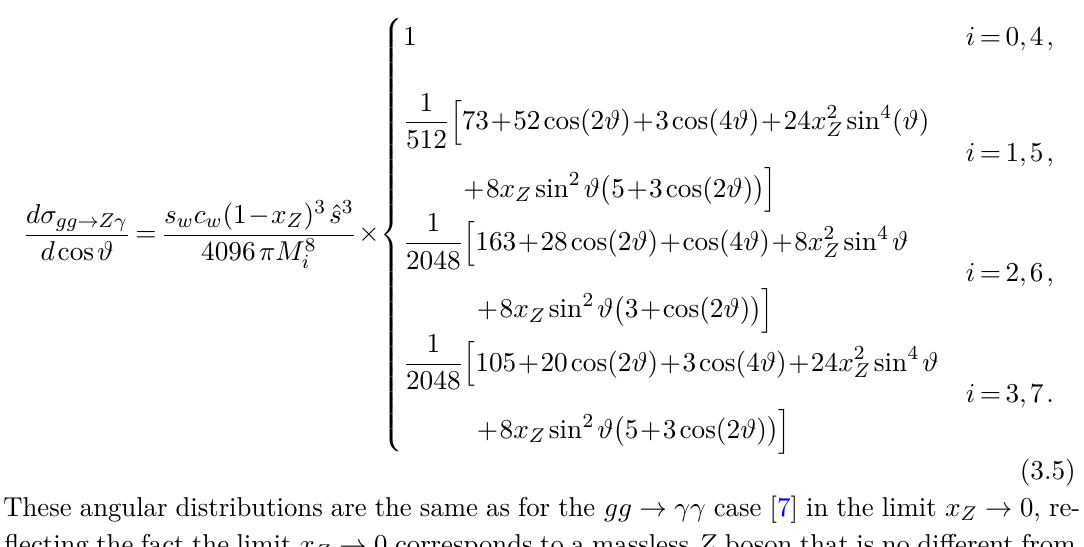
For comparison, the signal distribution is much less forward-backward peaked than the SM background. The differential cross sections for the gg → Zγ process generated by